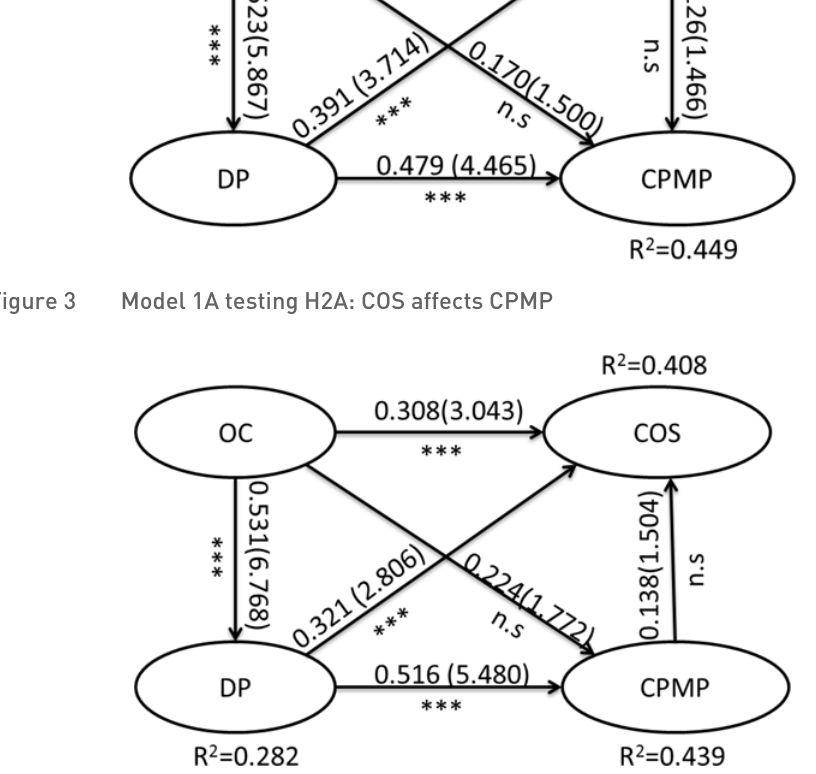
Figure 4 Model 1B testing H2B: CPMP affects